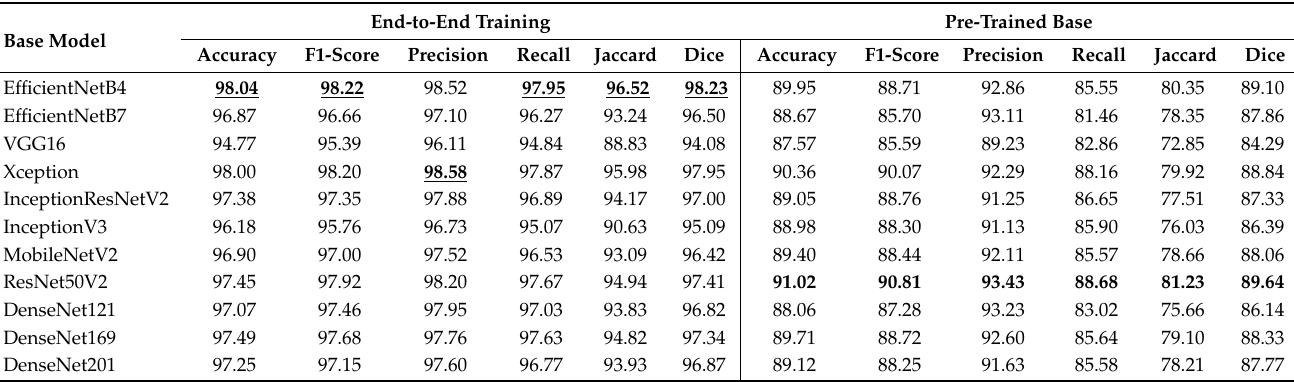
Table 2. Classification performance (%) of the examined deep neural network architectures following Approach 1 when using the pretrained weights for the base network and when training each network end-to-end. Base Model Recall Jaccard Dice EfficientNetB4